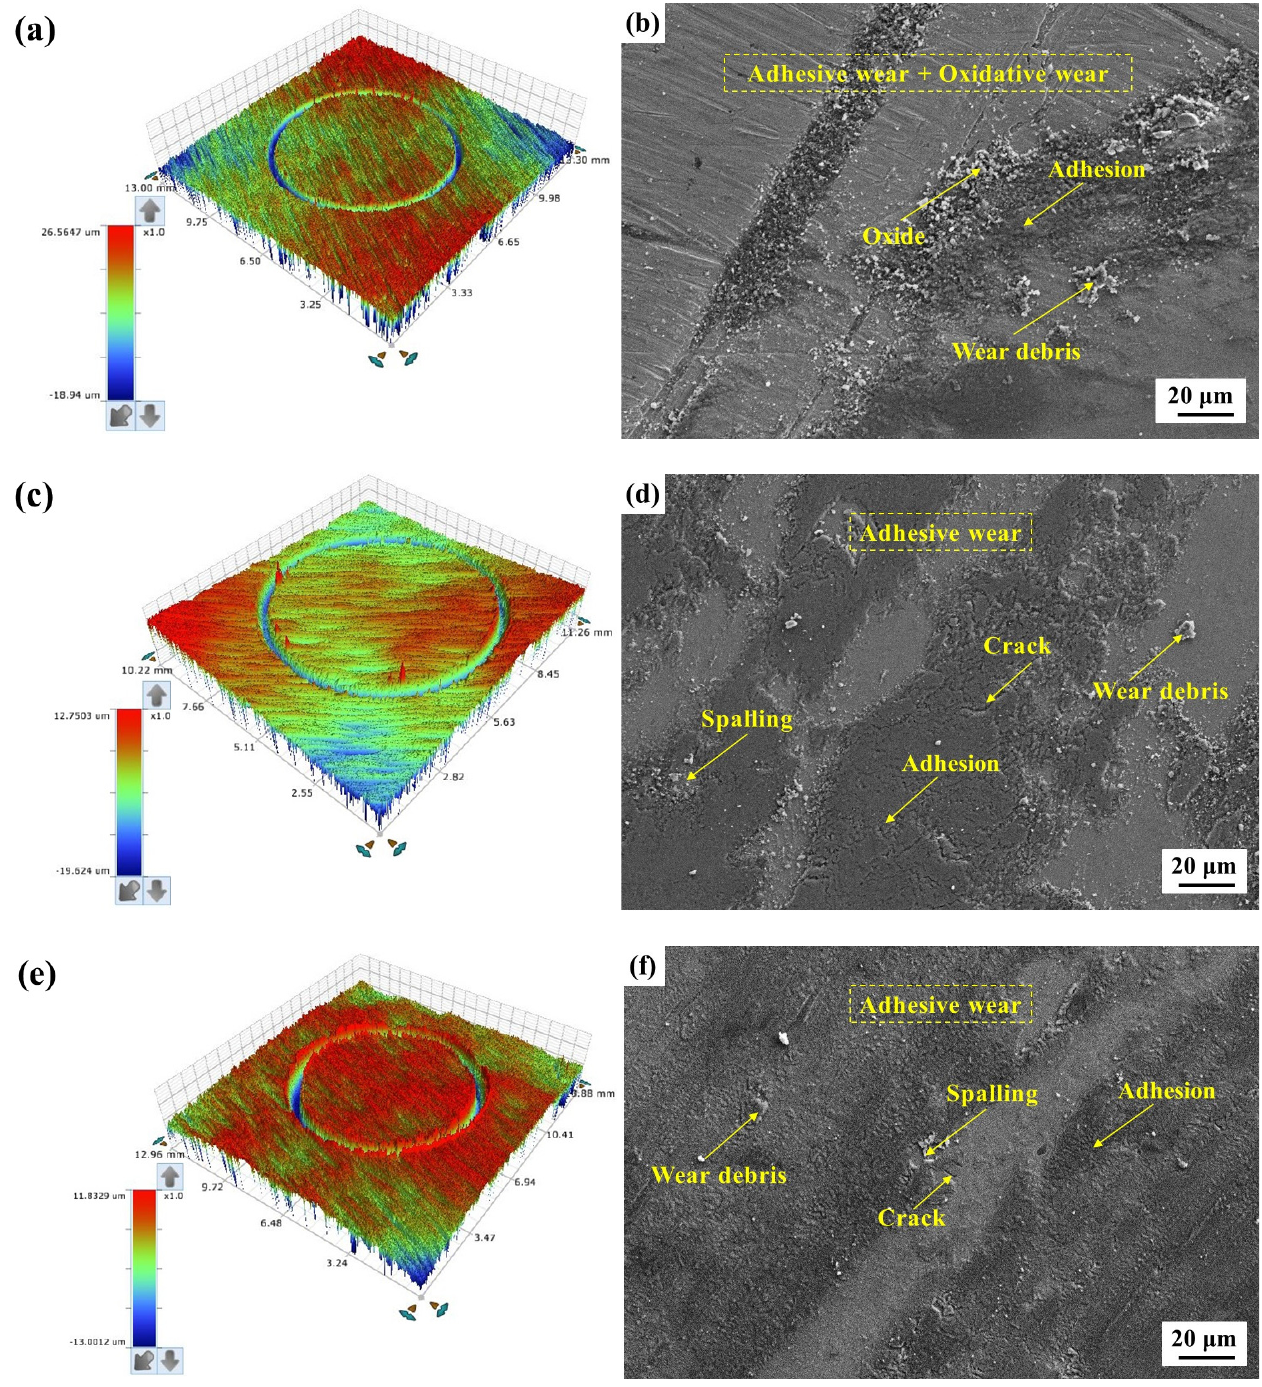
Figure 7. The 3D profile and the SEM images of wear morphology on the wear surface under a normal load of 40 N: ( a , b ) SKD11; ( c , d ) DC53; ( e , f ) SLD-MAGIC.